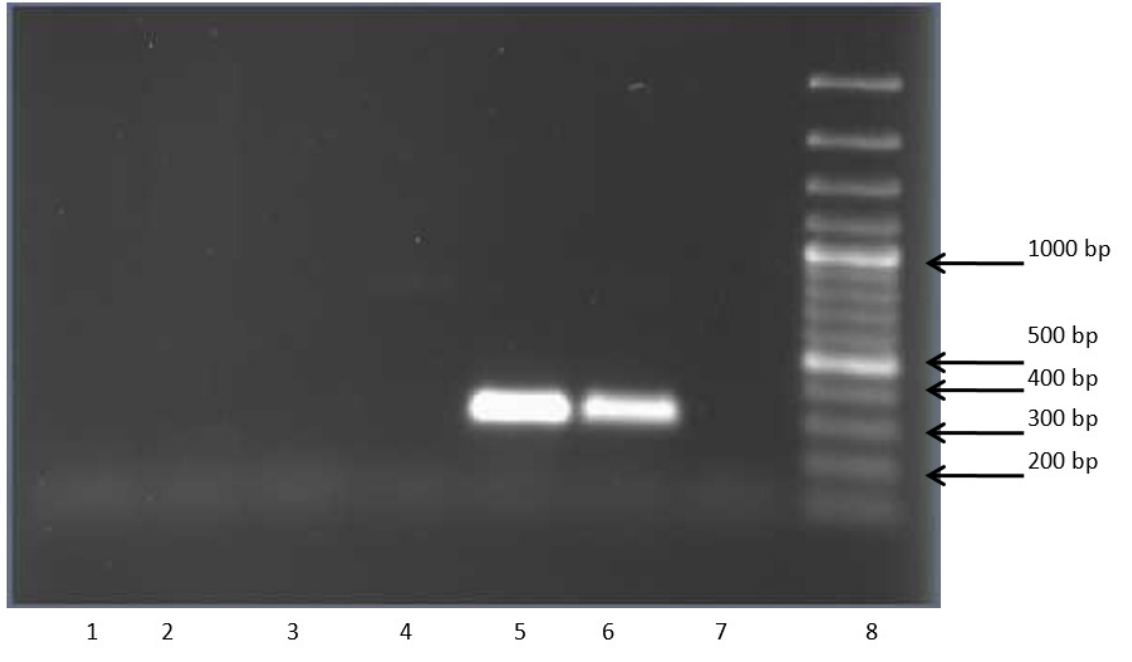
Figure 3. Electropherogram of clcF gene amplification products. 1— Rhodococcus rhodochrous 89, 2—